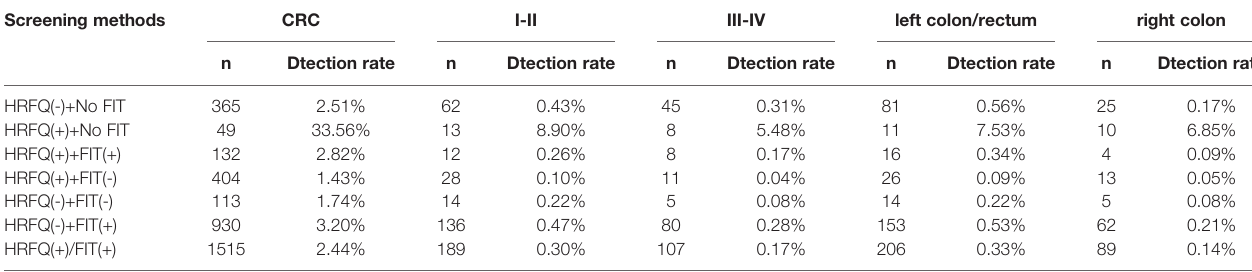
TABLE 11 | Staging and location distribution characteristics of different screening methods, (n). Screening methods